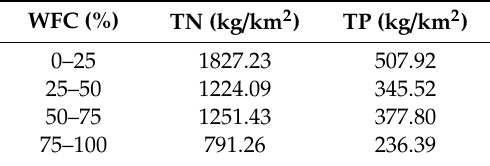
Table 6. The output of TN and TP in the watershed with di ff erent